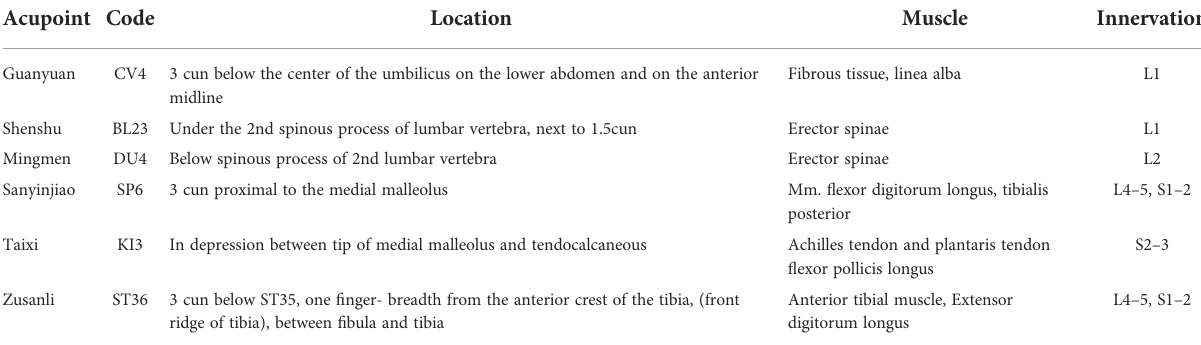
TABLE 2 The location, regional anatomy, and innervation of basic acupoints for male infertility. Acupoint